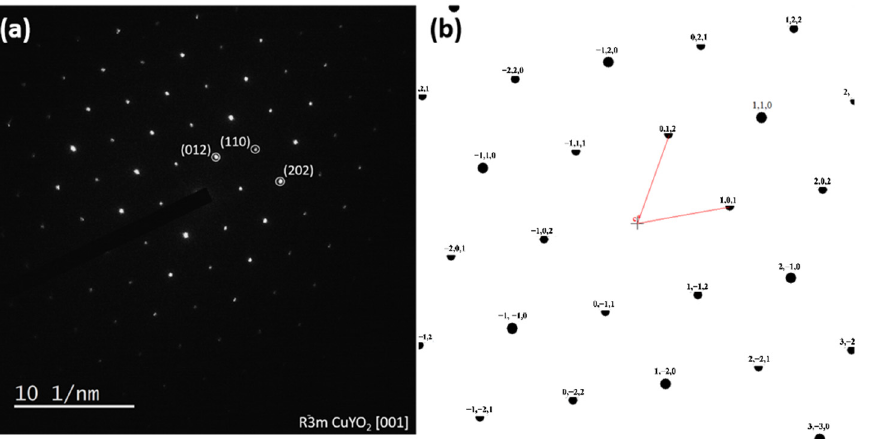
Figure 8. ( a ) SAED pattern of R 𝟑 m CuYO 2 nanofibers, ( b ) simulated diffraction pattern of R 3 m CuYO 2 .